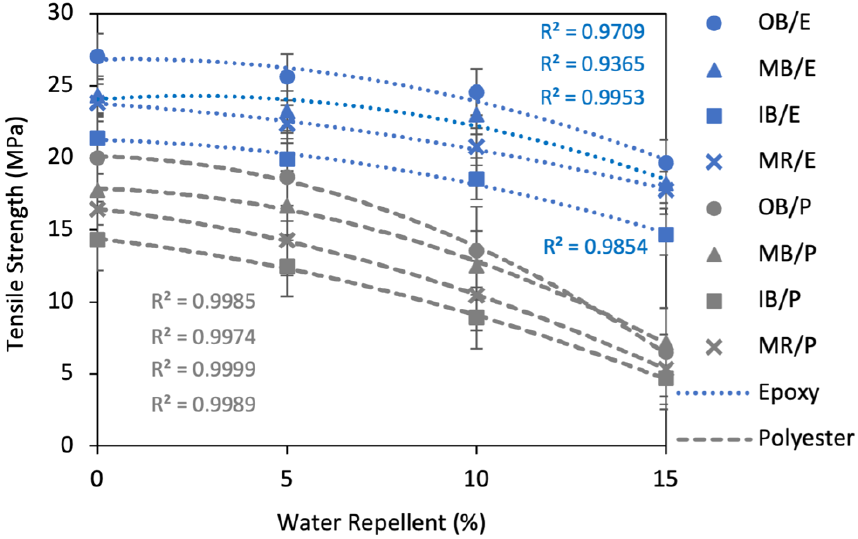
Figure 12. Effect of water repellent on the tensile strength of the